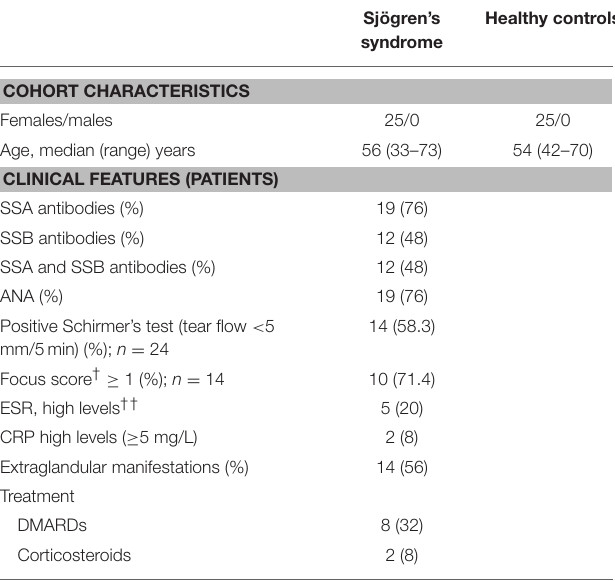
TABLE 1 | Characteristics of patients and controls used in